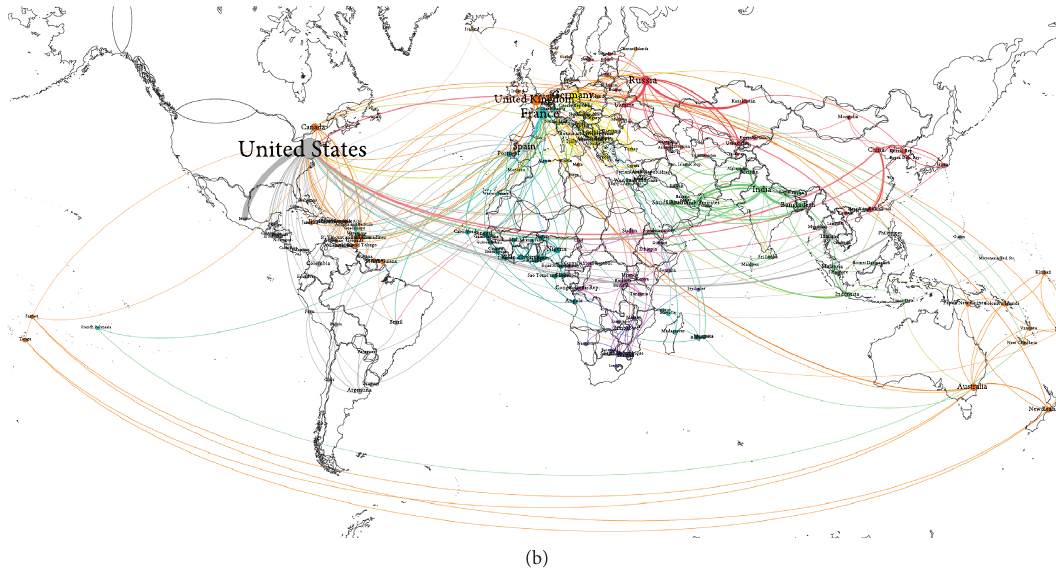
Figure 2: Backbone of the global migration network. (a) 1960–1969. (b)